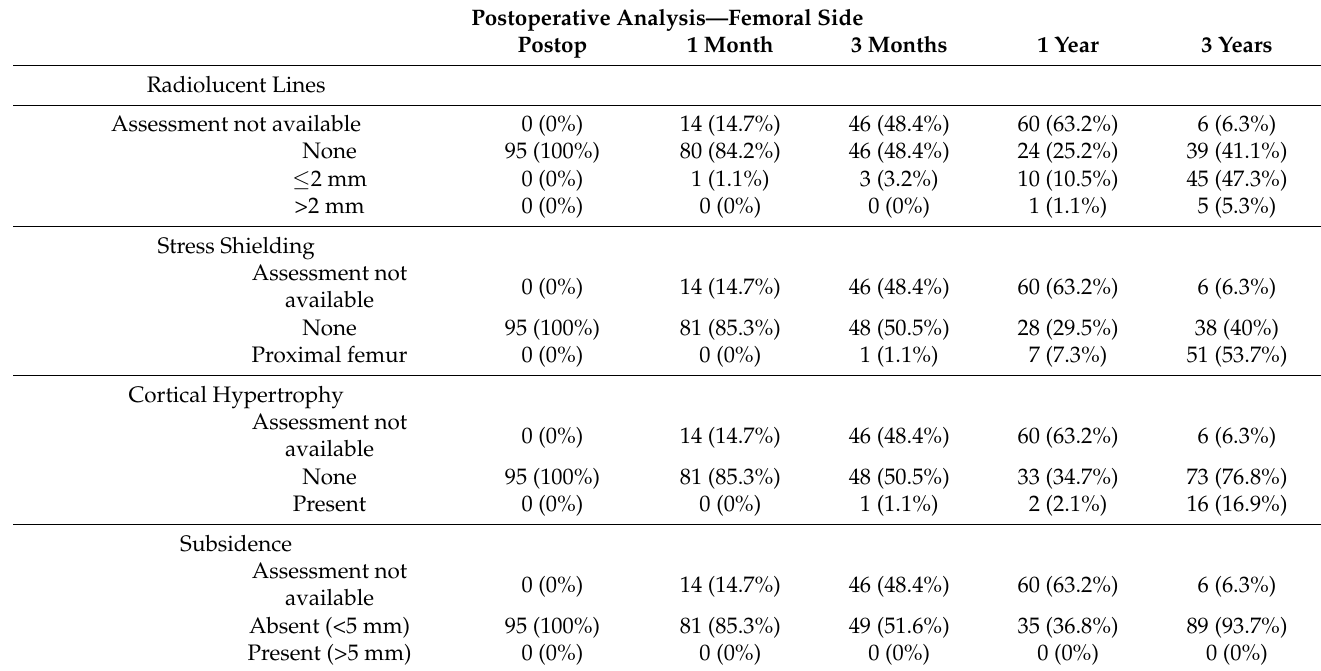
Table 3. Radiographic analysis of the femoral MINIMA S stem during follow-up. Postop: postoperative. Postoperative Analysis—Femoral Side Postop 1 Month 3 Months 1 Year 3